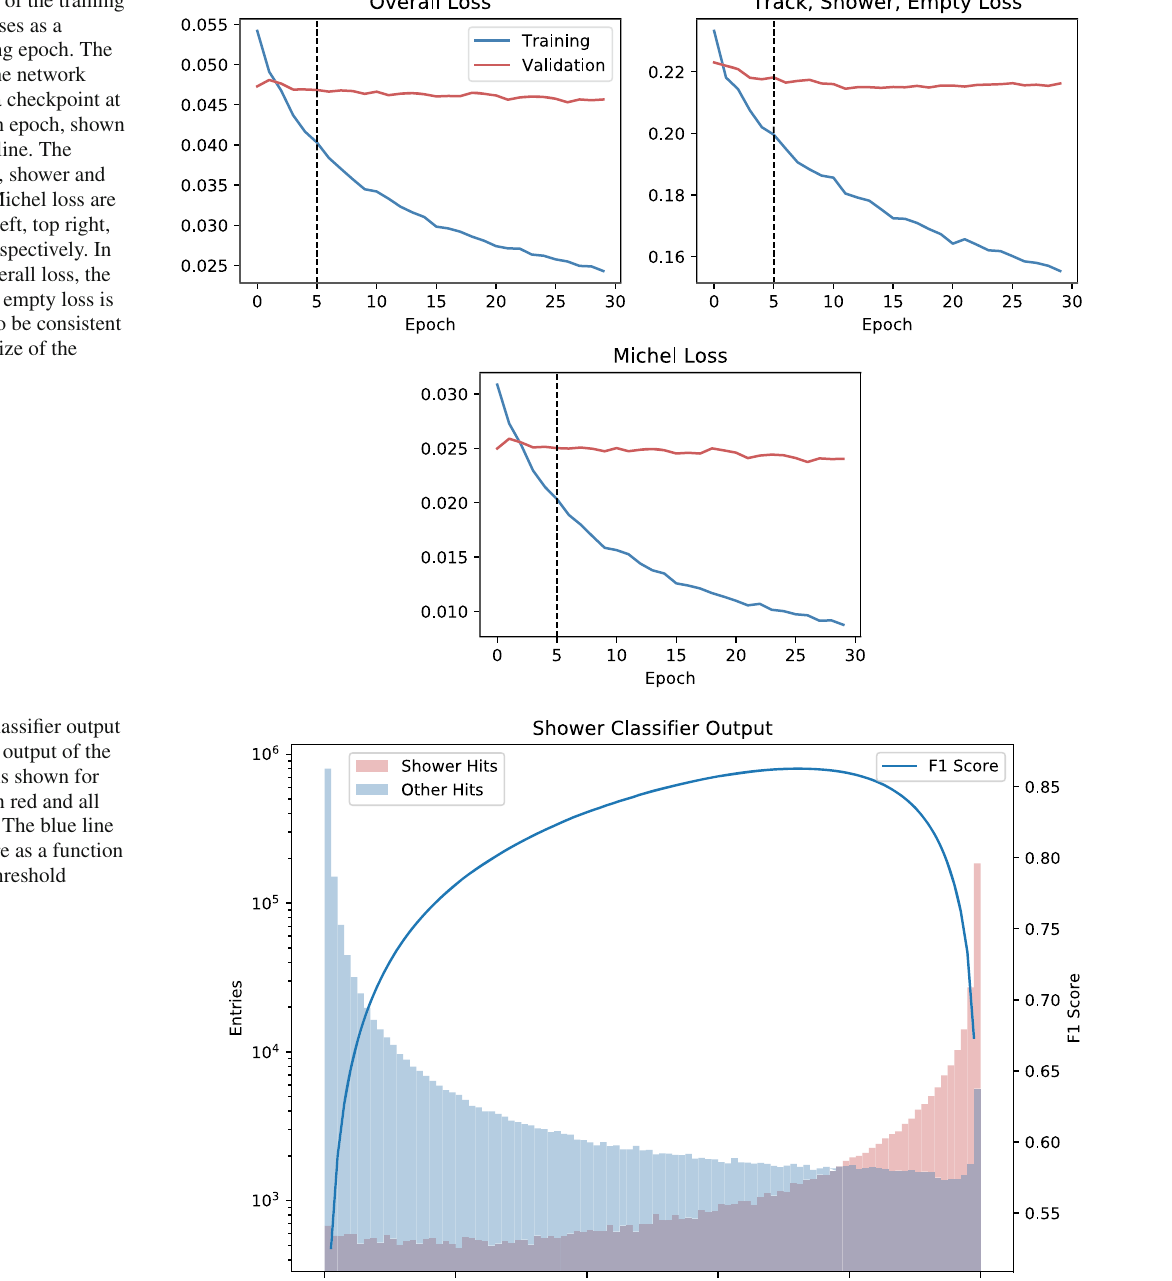
distributions. The output of the shower classifier is shown for true shower hits in red and all other hits in blue. The blue line shows the F1 score as a function of classification